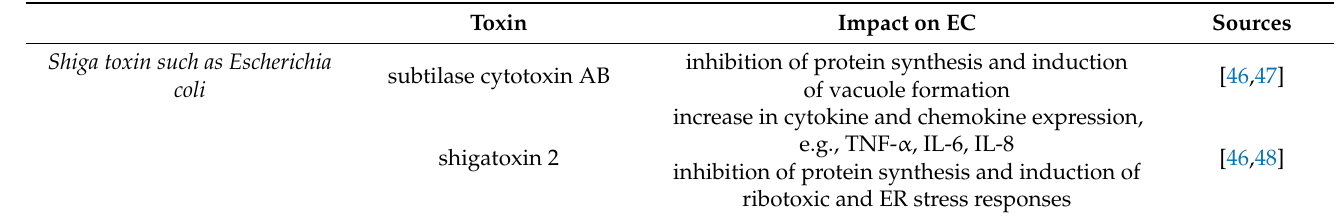
Table 1. Cont. Toxin Impact on EC